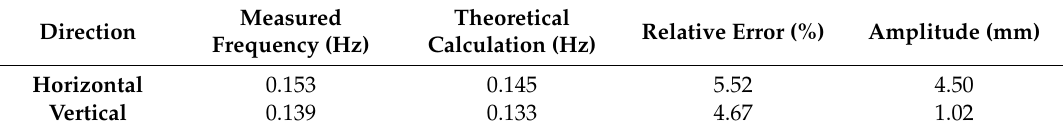
Table 4. Horizontal and vertical frequencies of the bridge structure and its